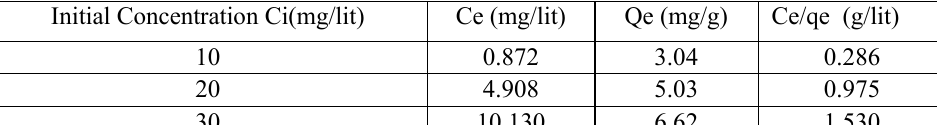
Table 6. Langmuir adsorption isotherm calculations for different initial concentrations.